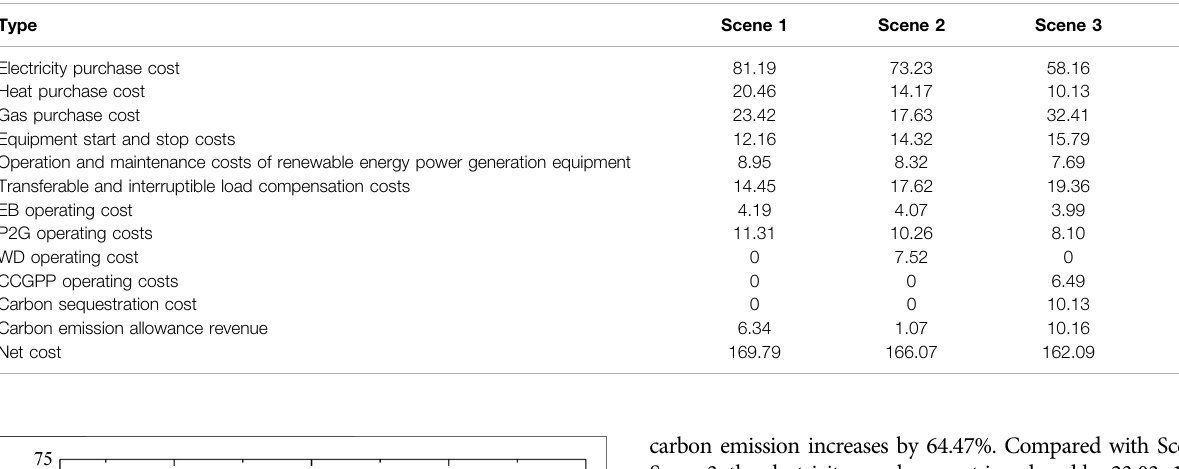
TABLE 2 | Comparison of optimization results in different scenes (*10 3 ¥).